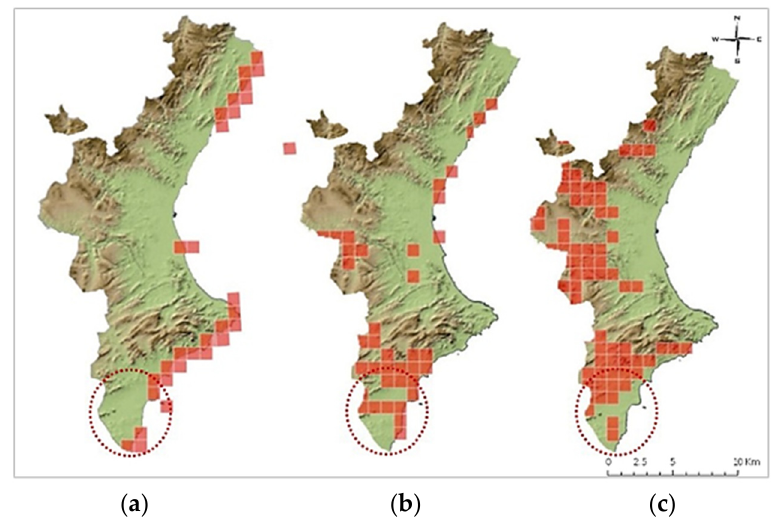
Figure 4. Location of the coastal habitats and halophytic vegetation in Vega Baja (Autonomous Community of Valencia). ( a ) Distribution of vegetated cliffs on Mediterranean coasts, with endemic Limonium spp; ( b ) distribution of Mediterranean salt steppes (Limonietalia); ( c ) distribution of the Iberian gypsiferous vegetation (Gypsophiletalia). Own elaboration based on [34] . Therefore, as a reference to quantify the benefit of preserving the ecosystem and bi- odiversity, the average value of the coastal habitats and halophytic vegetation was taken.